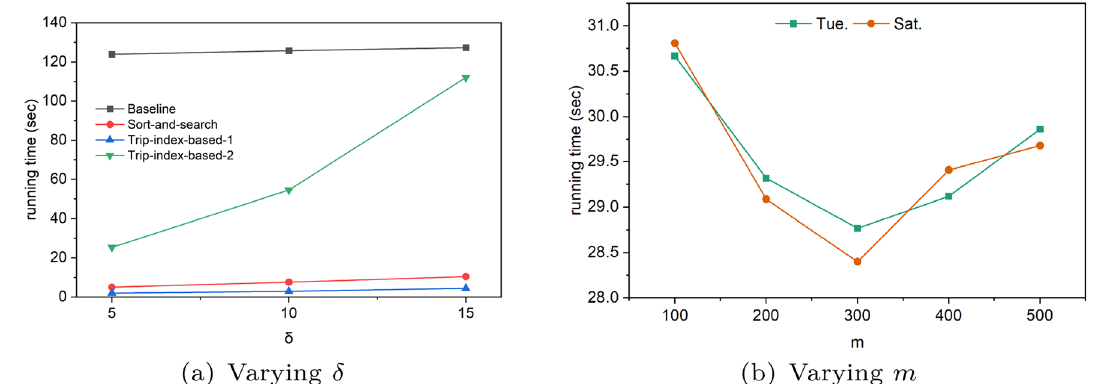
Fig. 17 Running time when 𝛿 or m